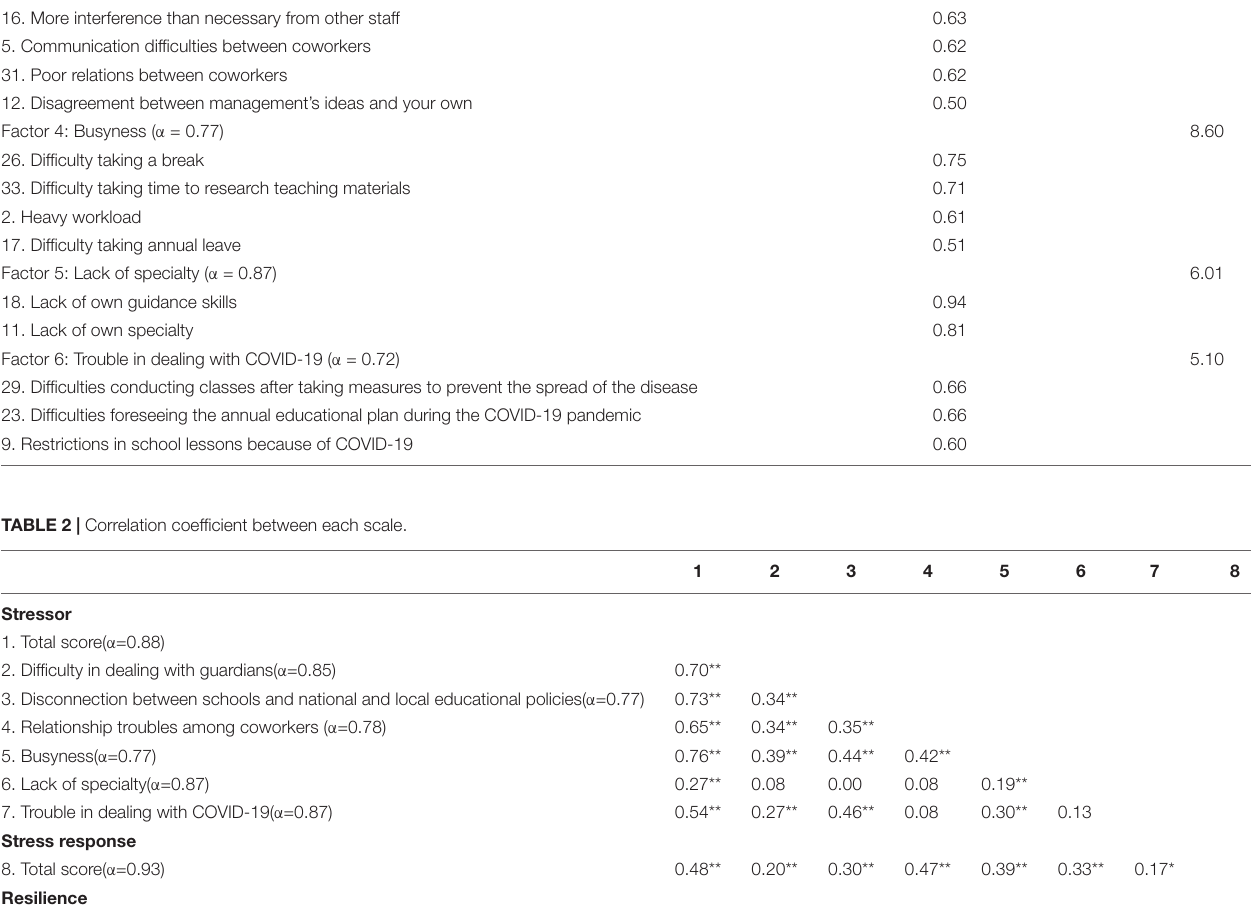
Factor loading % of Variance